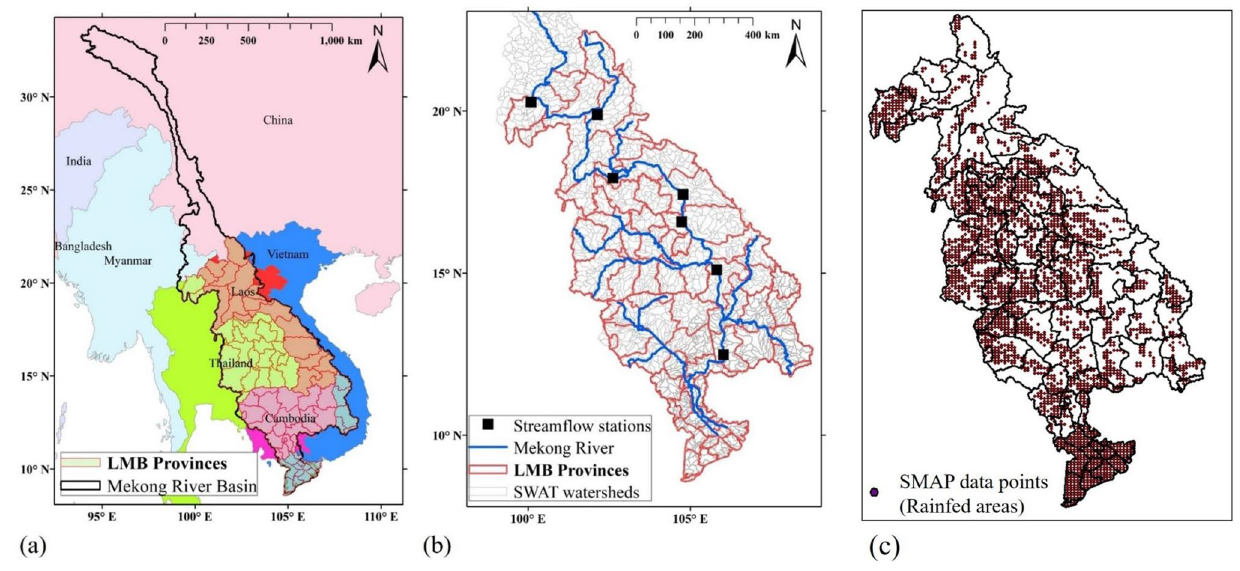
Figure 2. Study area. ( a ) Spatial map of the entire Mekong River Basin and the Lower Mekong Basin (LMB). ( b ) Spatial map of the LMB. Red lines indicate the boundary of provinces, blue lines represent the Mekong River, grey lines are the delineated SWAT sub-watersheds, and black and square boxes are streamflow stations for the SWAT calibration. ( c ) Soil Moisture Active Passive (SMAP) data points. Brown points indicate the SMAP data points where are intersected with the rainfed areas (3065 points). Spatial maps were created using ArcMAP10.5 software by Esri (www. esri.